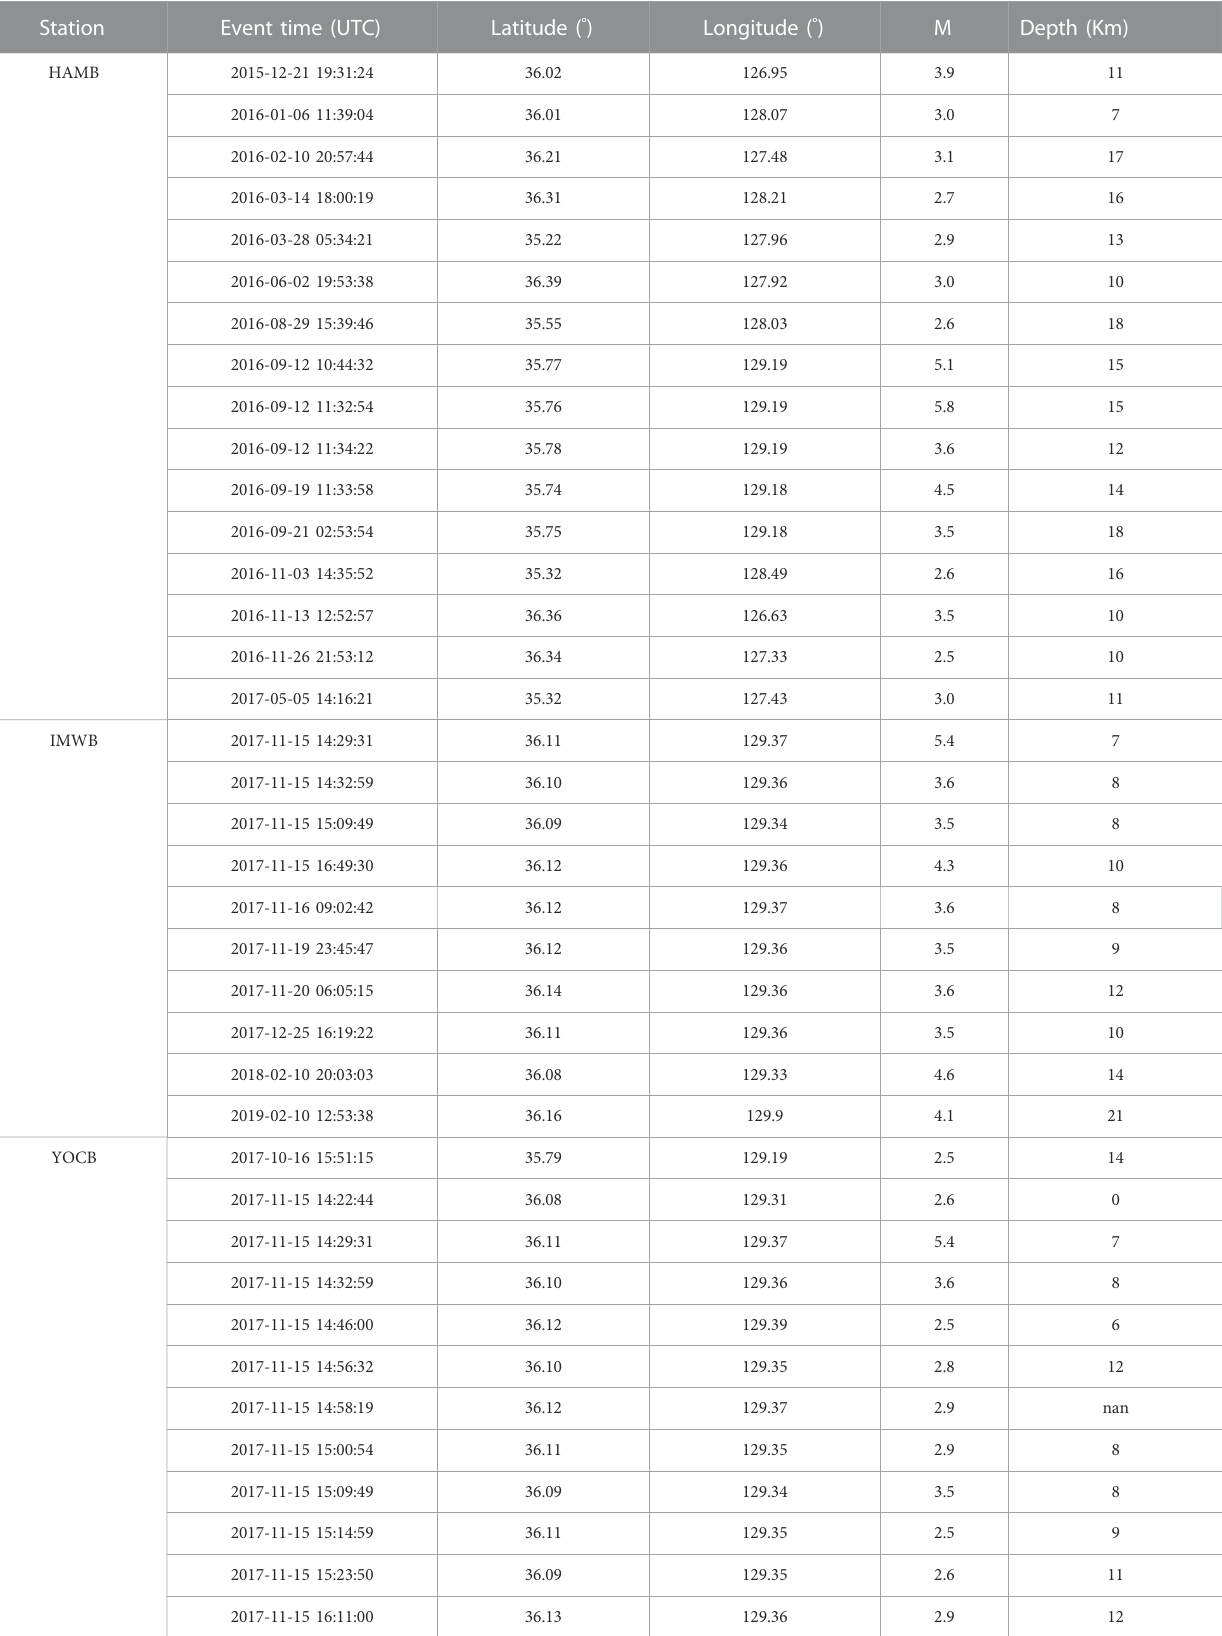
TABLE 1 Event Information during operation of temporary seismometers. Station Event time (UTC) Latitude ( ° ) Longitude ( ° ) M Depth (Km)